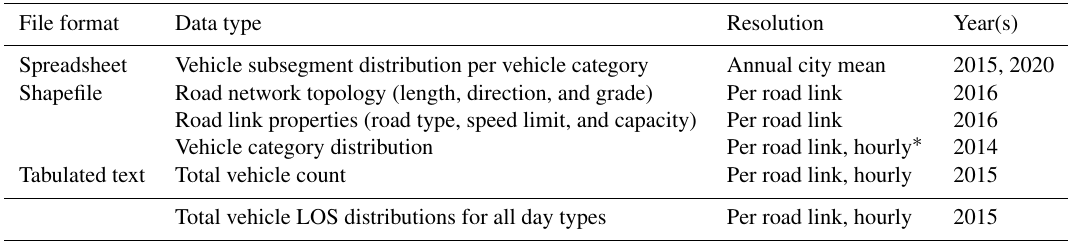
Table 3. Source data composite for the city of Berlin for generating Yeti input traffic data.